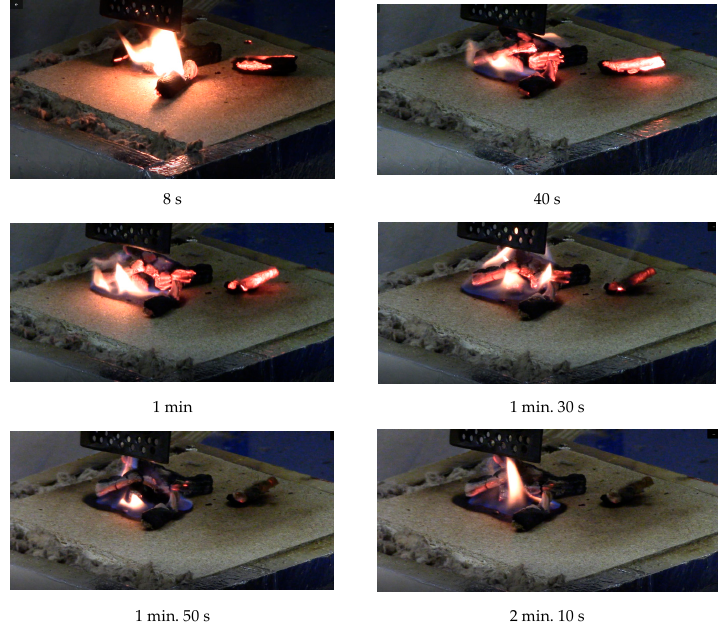
Figure 5. A group of images on the effect of firebrands on a chipboard sample. Figure 6 shows graphs comparing the ignition delay times of pine wood and construction materials (plywood and OSB-samples) depending on the number of firebrands at different wind speed. The wind speed was 2.0 m/s. It should be noted that the transition of firebrands from the glowing phase to the flame occurs due to the influx of the oxidizing agent from the heat blower. In particular, the transition occurred already at the 8th second in this case (Figure 5), which subsequently led to the burning of chipboard over the surface.